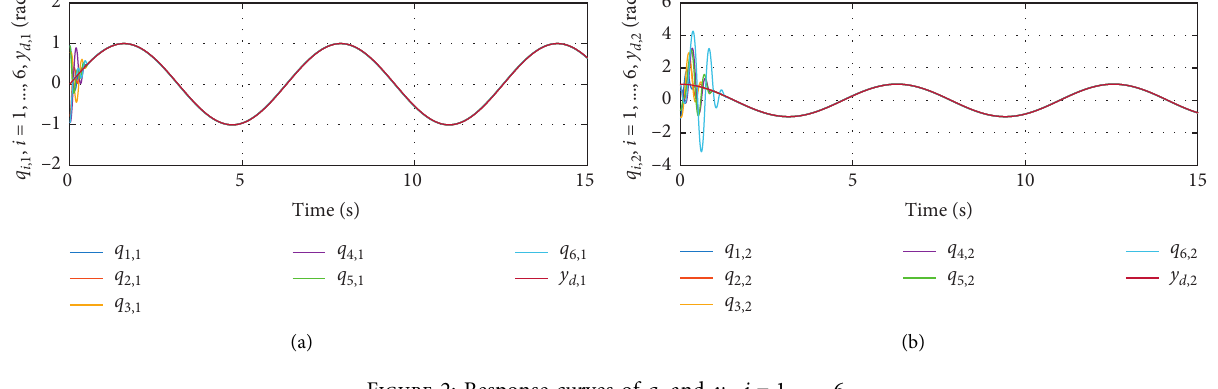
y , i � 1 , .. . , 6. i and d